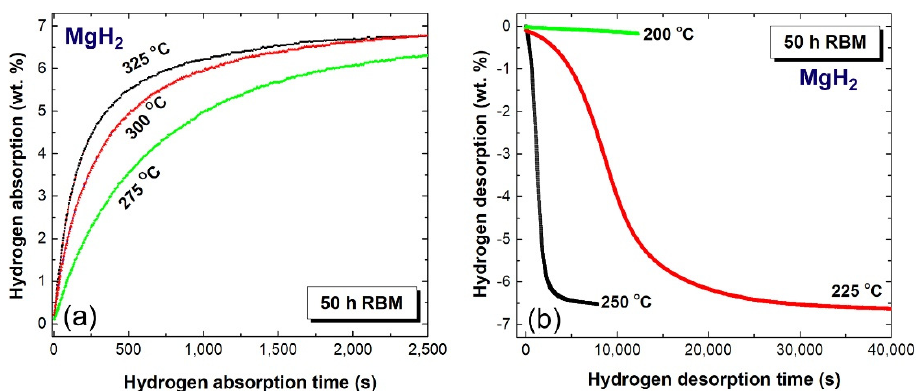
Figure 12. Kinetics measured at 275, 300 and 350 °C of ( a ) hydrogenation and ( b ) dehydrogenation of MgH 2 powders obtained after 50 h of RBM.